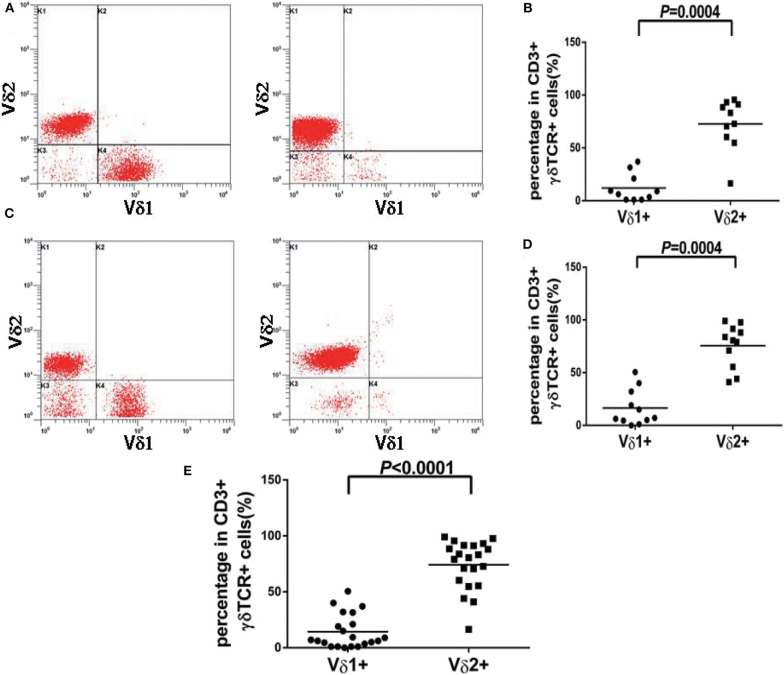
Vδ1 and Vδ2 expression pattern of γδT cell from normal controls and patients with reactively higher CD4 and CD8 double-negative ratio. (A) Representative peripheral blood samples from normal controls showed the normal distribution pattern of Vδ1 and Vδ2 in healthy individuals. (B) The percentages of Vδ2 positive events were significantly higher than Vδ1 in normal controls (p = 0.0004). (C) Representative peripheral blood samples or bone marrow samples from patients with reactively higher CD4 and CD8 double-negative ratio showed the normal distribution pattern of Vδ1 and Vδ2. (D) The percentages of Vδ2 positive events were significantly higher than Vδ1 in patients with reactively higher CD4 and CD8 double-negative ratio (p = 0.0004). (E) The percentages of Vδ2 positive events were significantly higher than Vδ1 in all 21 cases without TCL (p < 0.0001).